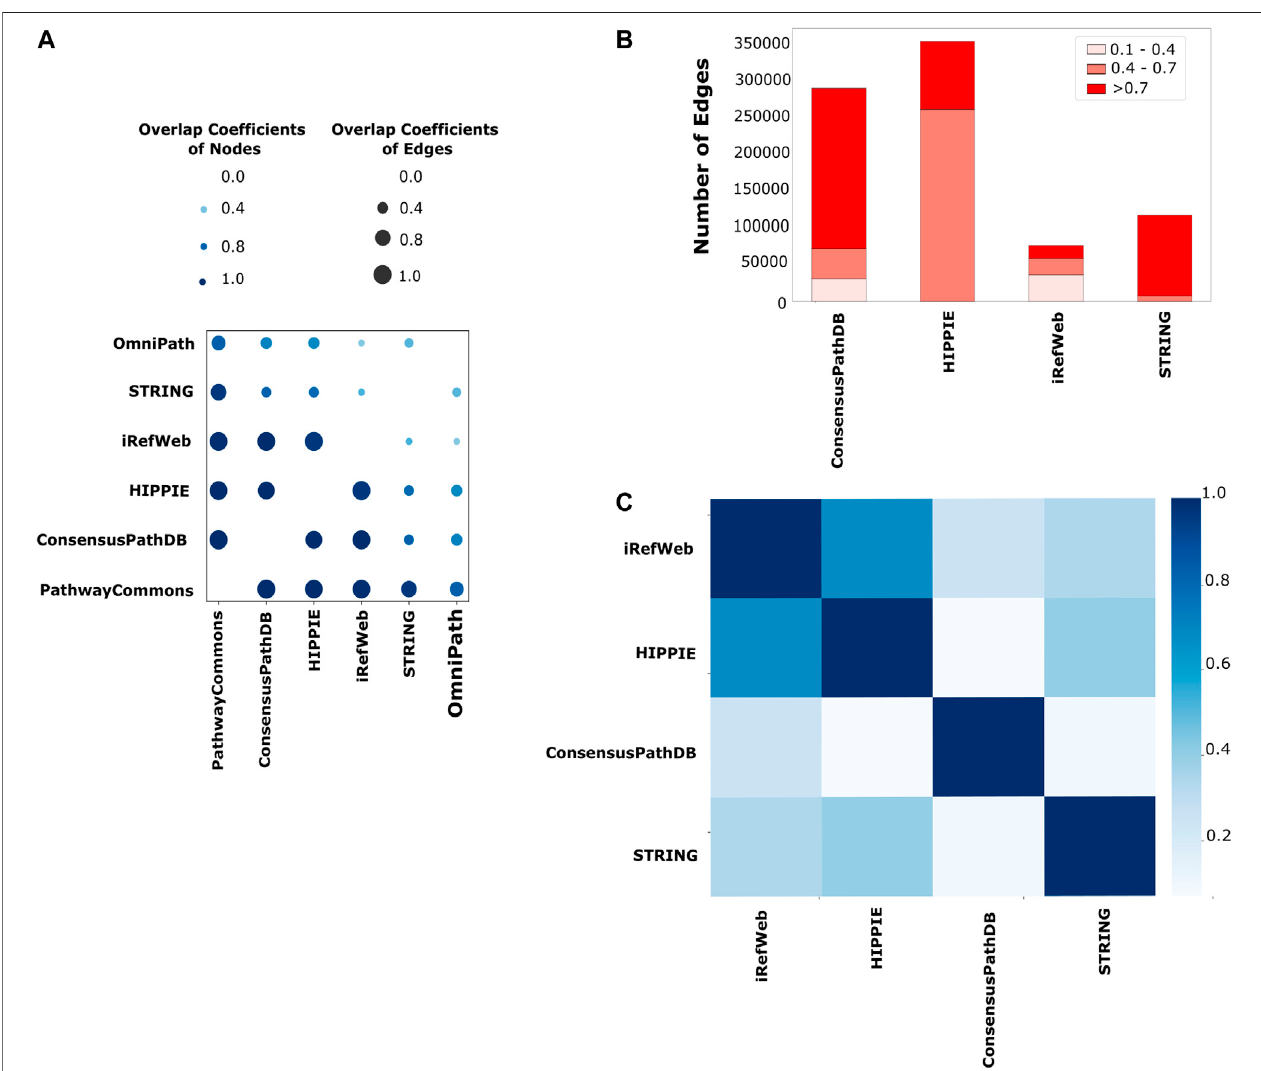
FIGURE 2 | Comparison of the reference interactomes. (A) Node- and edge-level commonalities between different interactomes; the node overlap score is displayed on a light-to-dark blue-color scale, while the edge similarity score is shown on a size scale where the higher similarity is represented with the larger circle. (B) Scores are categorized as low con fi dence between 0.1 and 0.4, medium con fi dence between 0.4 and 0.7, and high con fi dence between 0.7 and 1.0 for each interactome.PathwayCommonsandOmniPatharenotdemonstratedhereduetothelackofacon fi dencescorefortheiredges.Edgeswithlowcon fi dencescores are mostly seen in iRefWeb and small portions of edges in ConsensusPathDB have low con fi dence scores, while low con fi dence edges are not seen in the fi ltered STRING and HIPPIE. (C) Different strategies on con fi dence score calculation are used in interactomes. Using their common edges, the correlation coef fi cients among their con fi dence scores over interactomes are demonstrated in the heatmap. The highest correlation between HIPPIE and iRefWeb is seen with the darkest blue. The same con fi dence score calculation strategy, MI scoring, is used in both interactomes.